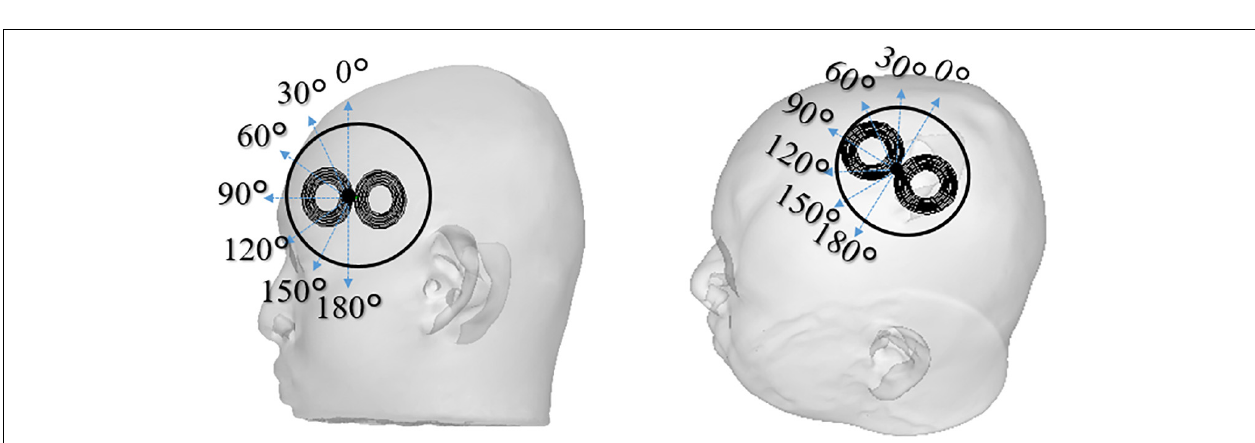
FIGURE 1 | Individualized head models derived from MR images considering non-brain tissues. The model is used to obtain the induced electric field on skin and brain. In addition, a volumetric model of the head tissues is used as reference to determine the electric field values on different tissues.